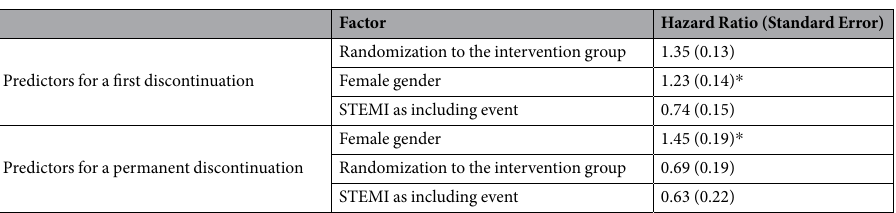
Table 2. Predictors for a first and permanent discontinuation. Non-proportional hazard for female gender. * Mean hazard ratio during the studied period. p < 0.05 for all